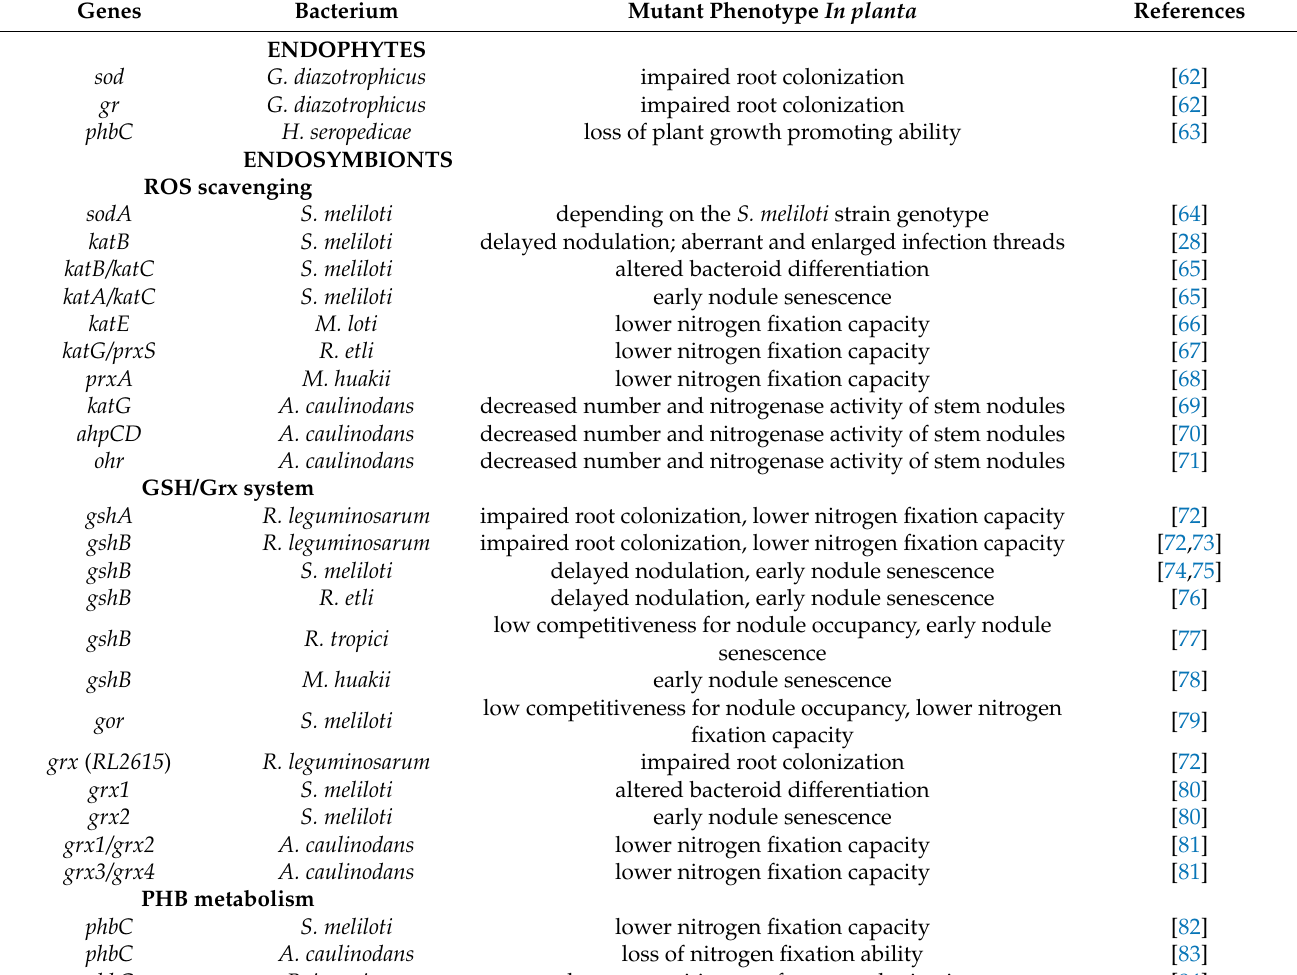
rhizosphere bacterial growth and root colonization, while gshA and gshB are required for rhizosphere competitiveness and onward stages of symbiosis as well [72]. Table 1. Genes of diazotrophic rhizobia involved in cellular redox homeostasis and in the efficiency of endo- phytic/endosymbiotic interaction. Phenotypes in planta are the results of gene inactivation except for S. meliloti katB mutant that overexpresses katB . PHB,